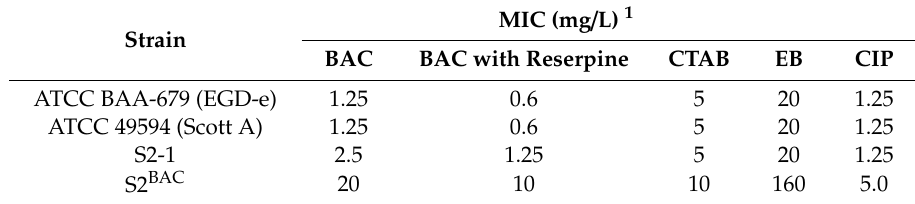
Table 1. Minimum inhibitory concentrations (MICs) of different compounds for BAC-S and BAC-R strains.